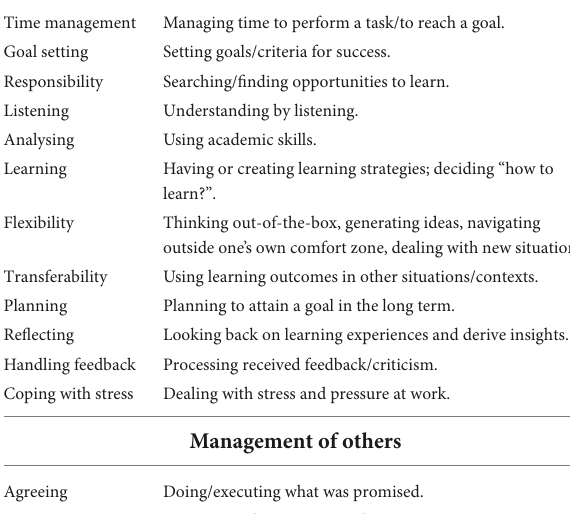
TABLE 3 Generic skills categorisation with four generic skills categories adapted from Dunne (see Bennett et al., 1999), with the names of the skills on the left and skill definitions on the